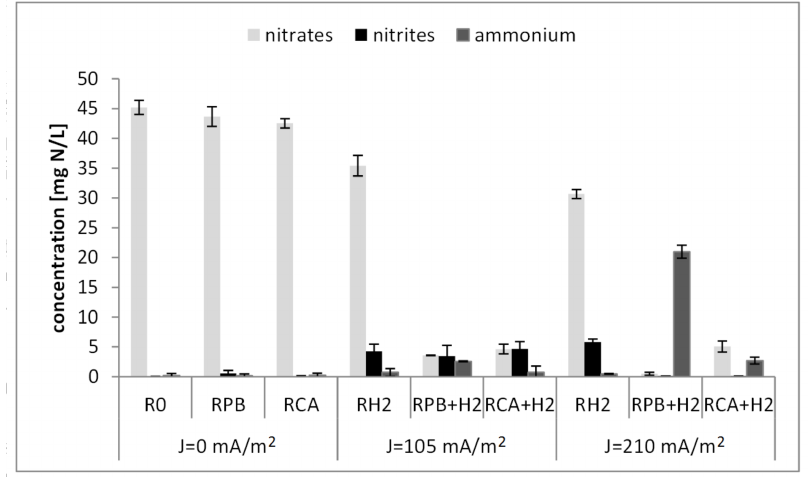
Figure 4. The concentration of nitrogen compounds in treated wastewater: R 0 —control reactor, without an electric current flow and without an external carbon source; R PB —reactor without an electric current flow and with a potassium bicarbonate dosage; R CA —reactor without an electric current flow and with an acetic acid dosage; R H2 —reactor with an electric current flow and without an external carbon source; R PB+H2 —reactor with an electric current flow and with a potassium bicarbonate dosage; R CA+H2 —reactor with an electric current flow and with an acetic acid